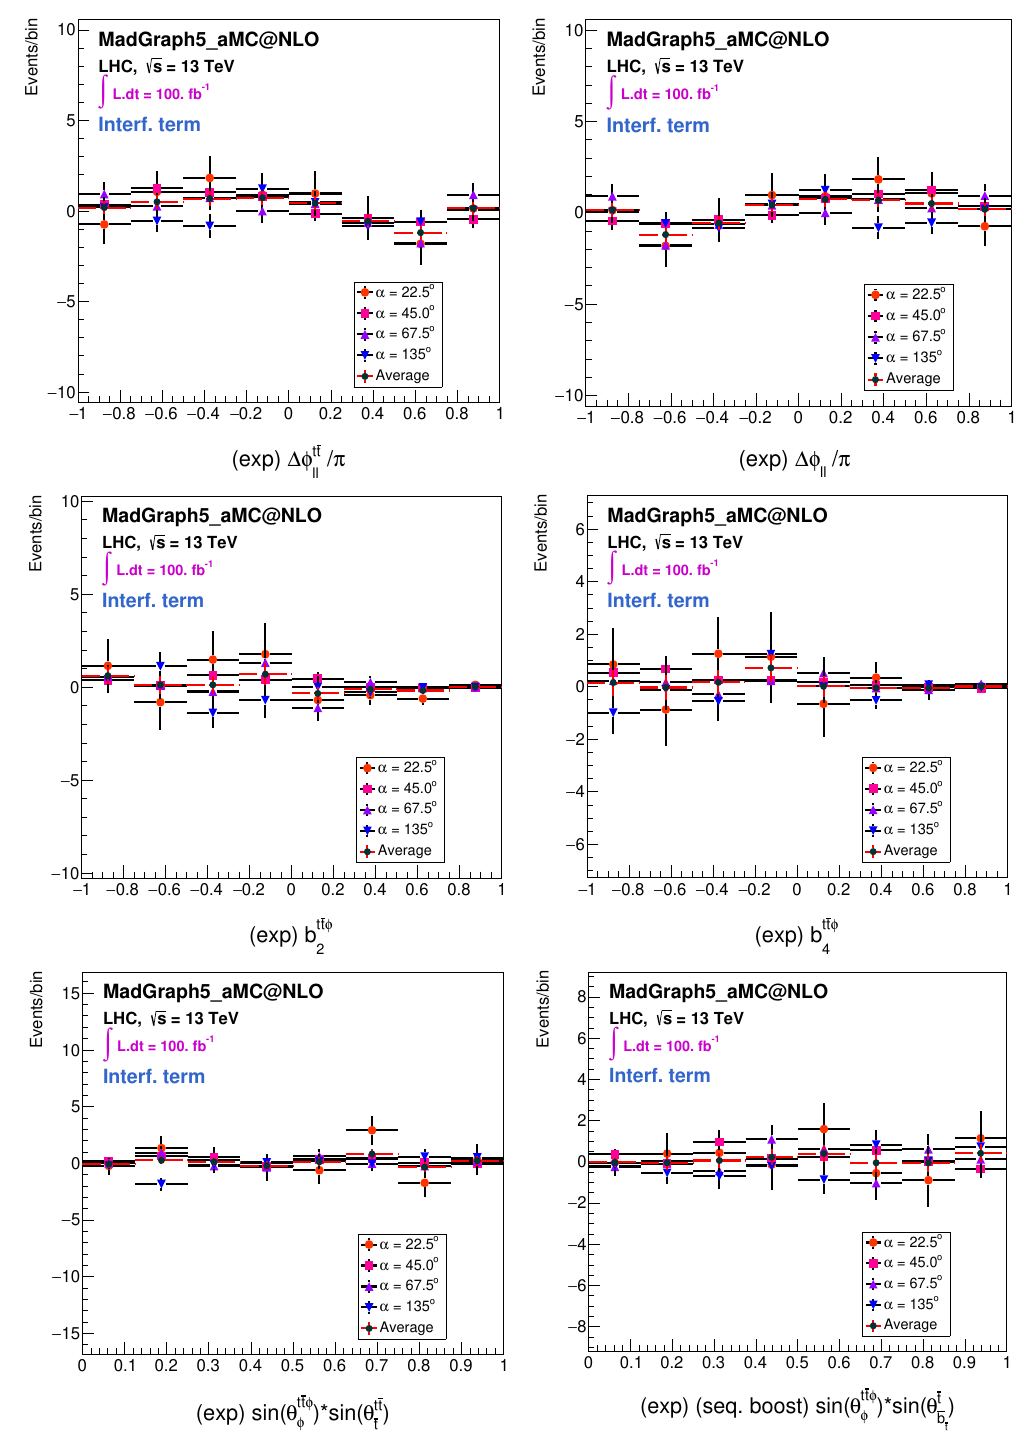
Figure 5 . The scalar-pseudoscalar interference term is represented, after event selection and kinematic reconstruction, for several sensitive CP variables, in t ¯ tφ production at the LHC, for a reference luminosity of 100 fb − 1 . Different t ¯ tφ signals, with mixing angles set to α = 22 . 5 o , 45 . 0 o , 67 . 5 o and 135 o are used to extract the interference